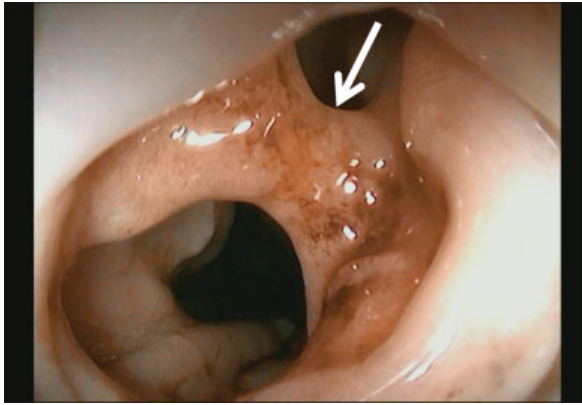
Fig. 2 Endoscopic view of the mucosal bridge (white arrow) at the level of the gastroesophageal